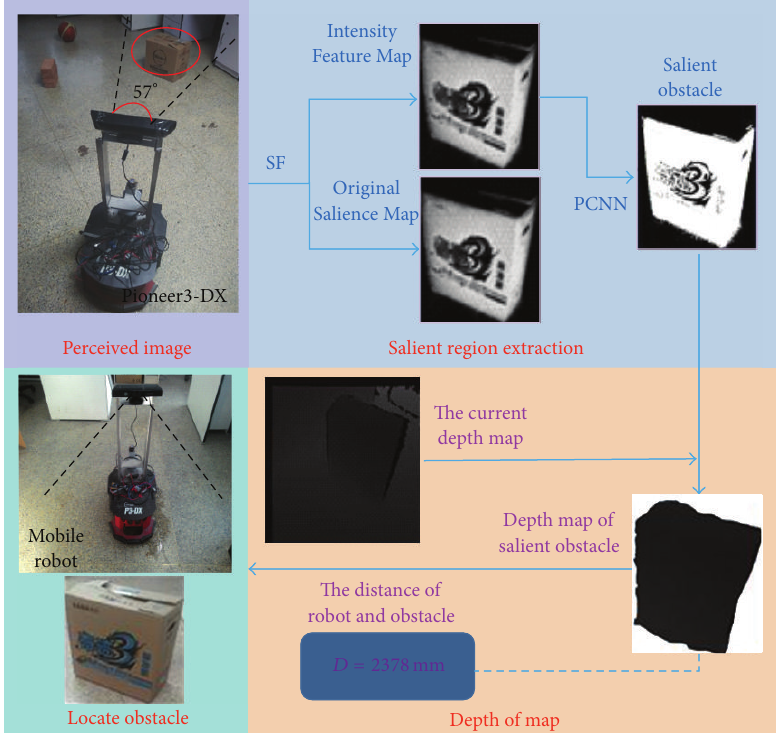
Figure 1: Frame diagram of our model’s